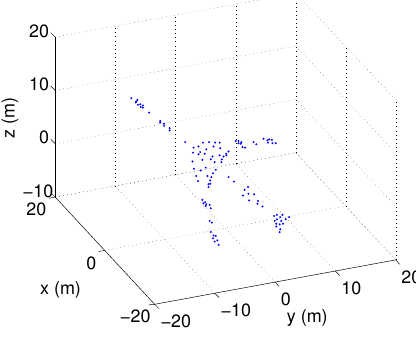
Figure 3. 3-Dimensional (3-D) scatterer model of